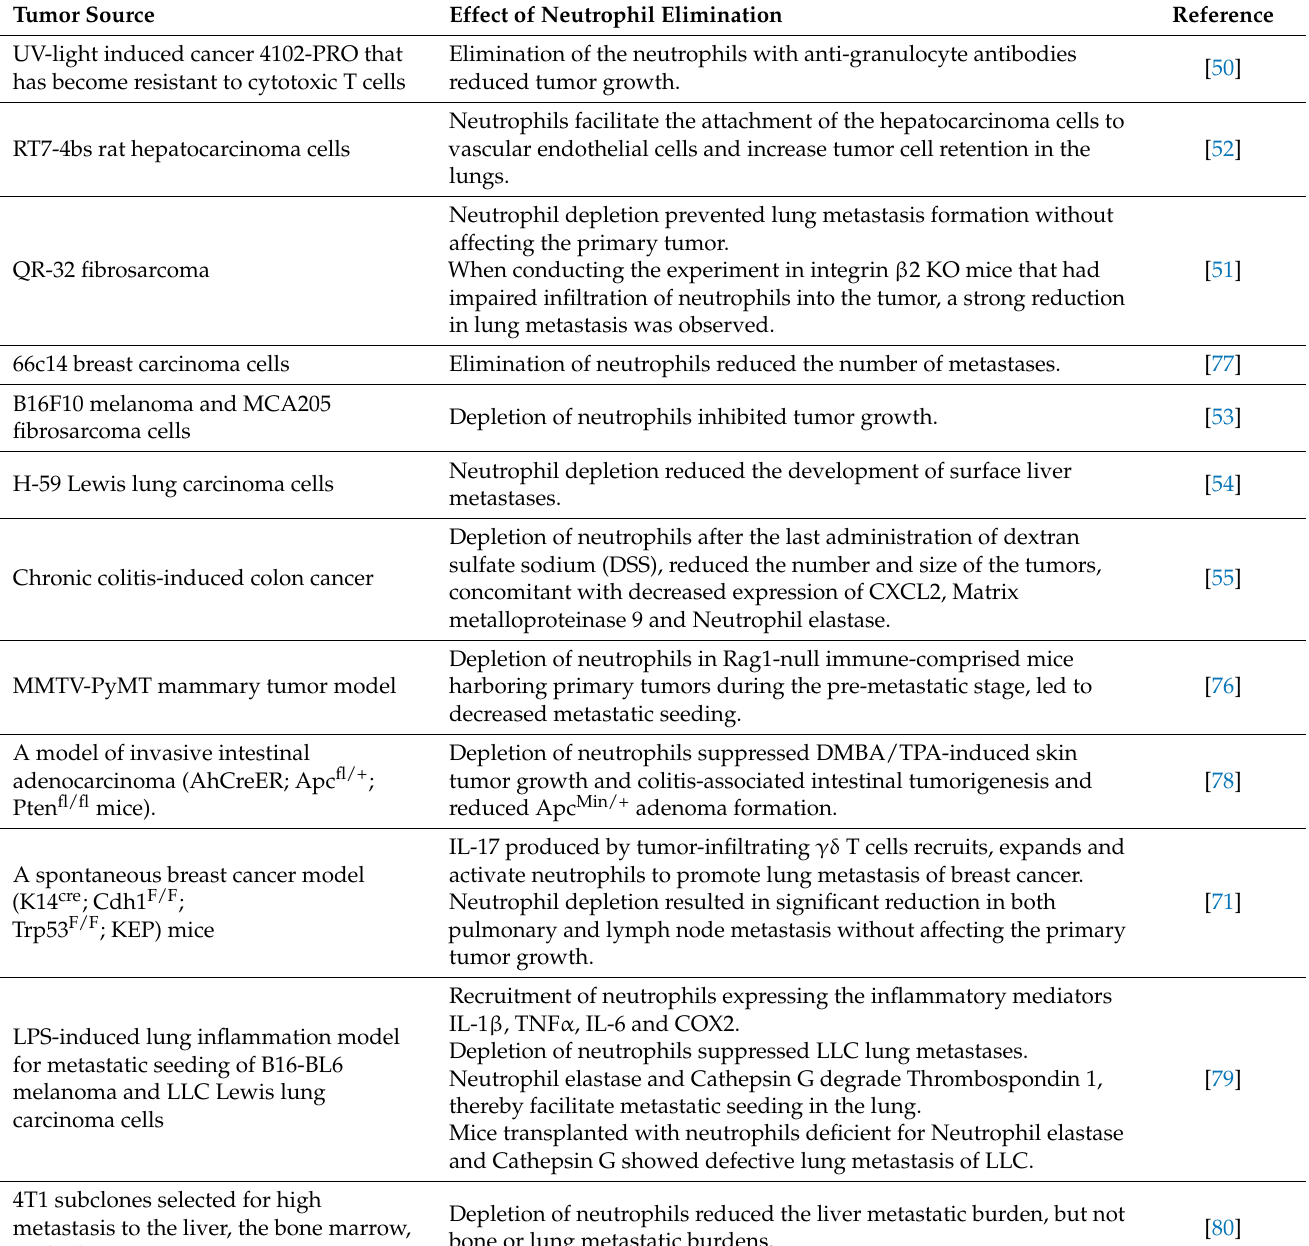
Table 1. Examples of tumor models showing pro-tumor neutrophil